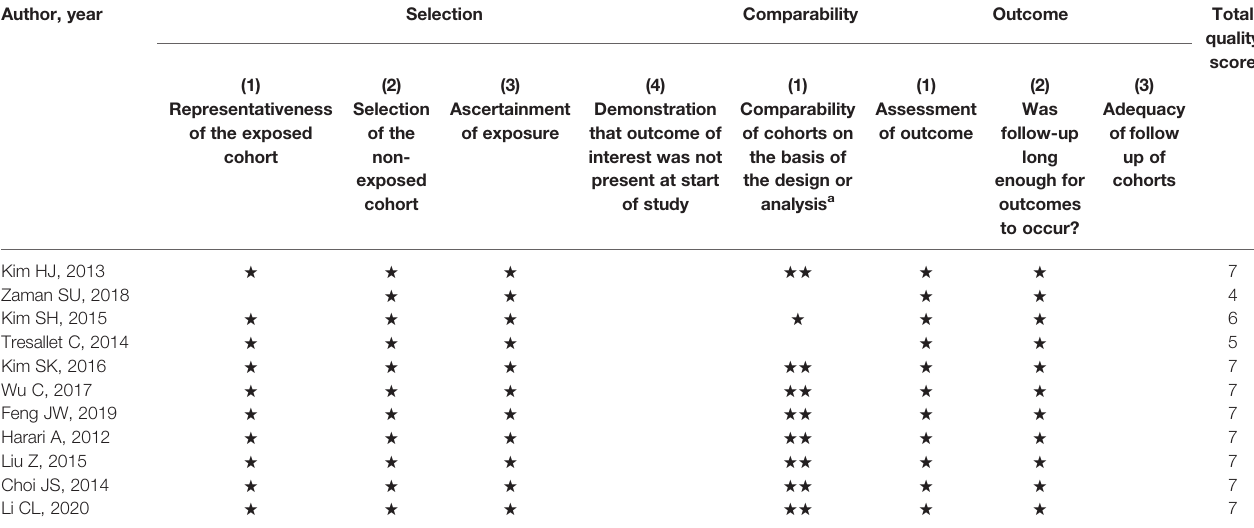
TABLE 3 | Quality assessment of cohort